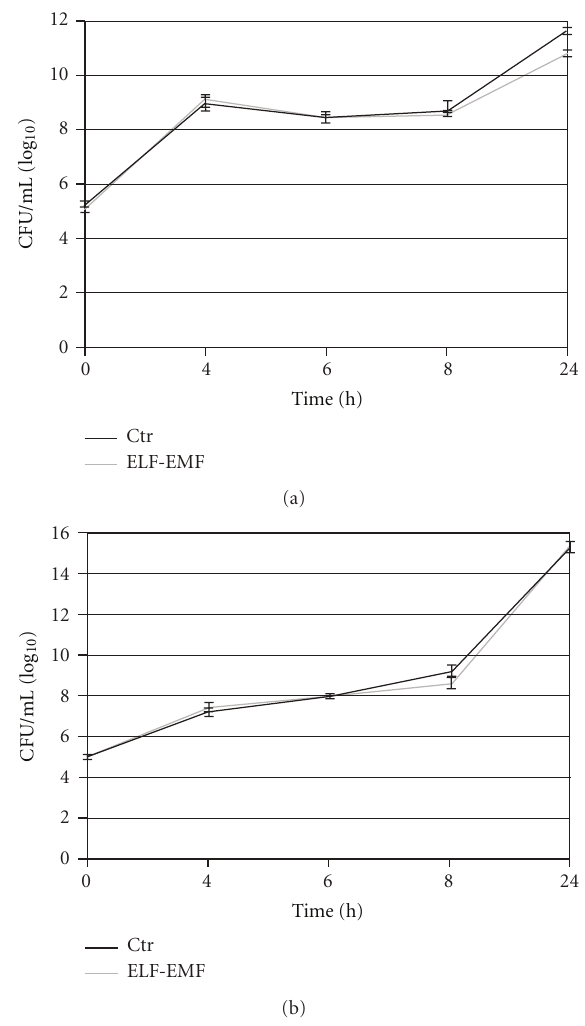
Figure 2: E ff ect of ELF-EMF (sinusoidal wave; 2mT; 50Hz) on growth rate of E. coli (a) and P. aeruginosa (b). ELF-EMF: ELF-EMF exposed groups; Ctr: control groups. Data represent means ± SEM from 3 di ff erent